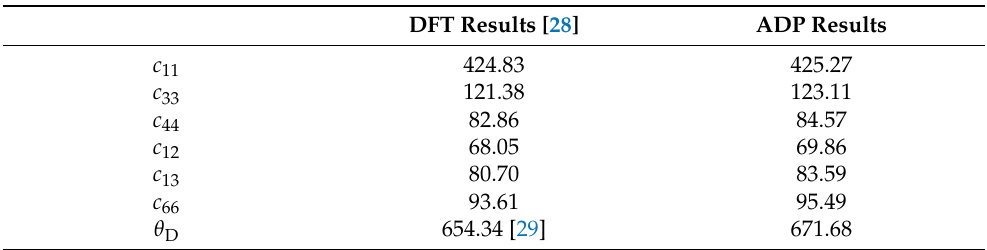
Table 2. Comparison of elastic stiffness (constant c ij in GPa) and Debye temperature θ D (in K) between ADP results and previous DFT